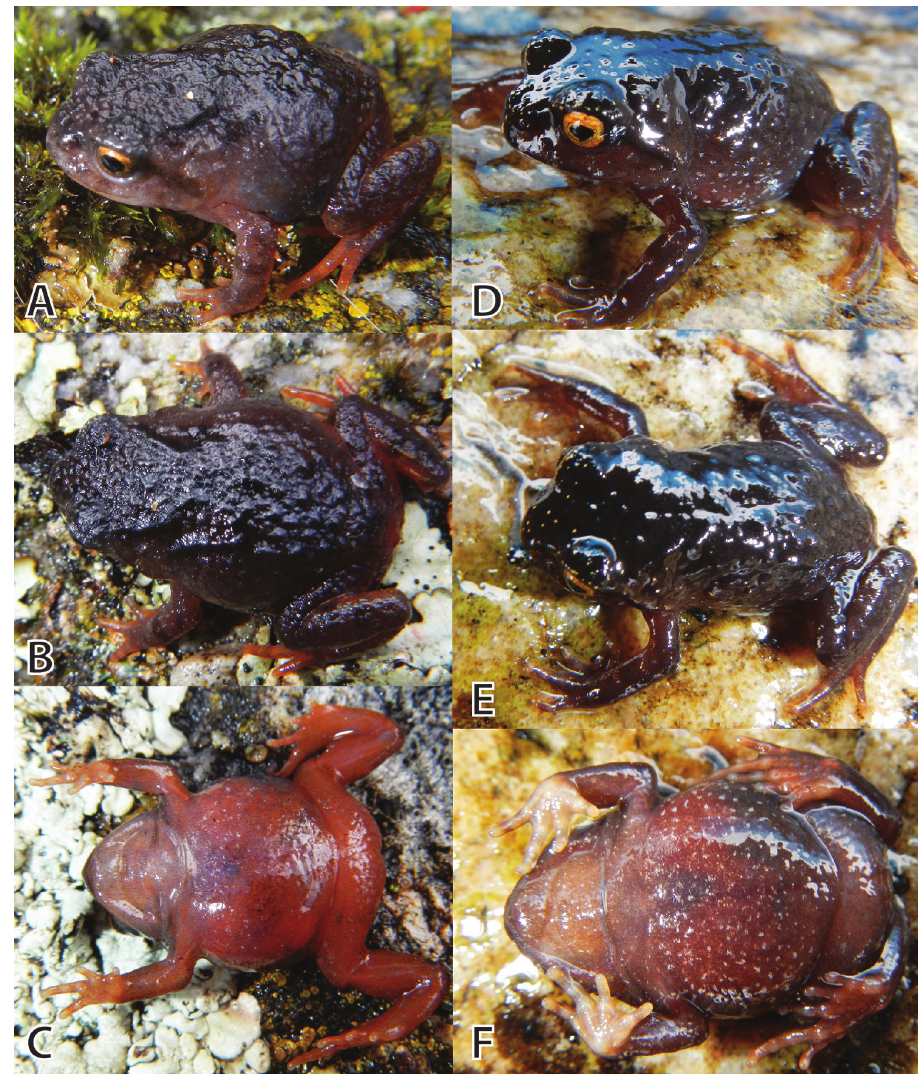
Figure 9. Variation of juvenile paratypes of Phrynopus inti sp. n. in dorsolateral, dorsal, and ventral views. A–C (MUSM 31969, SVL 16.0 mm), D–F (NMP6V 75587, SVL 20.3 mm). Photos by E. Lehr. 2012 at 3609 m a.s.l. (Fig. 10C). The vegetation at the type locality consists of Polylepis trees, small bushes, ferns, moss, and Peruvian feather grass. No sympatric anurans were recorded. One specimen (MUSM 31203) was found in the afternoon under moss in a Polylepis forest patch near the trail from Tasta to Tarhuish at 3886 m a.s.l. Three speci- mens (MUSM 31968, 31969, UMMZ 245220) were collected in the morning under rocks and in moss in the mountain slopes of the Toldopampa valley close to